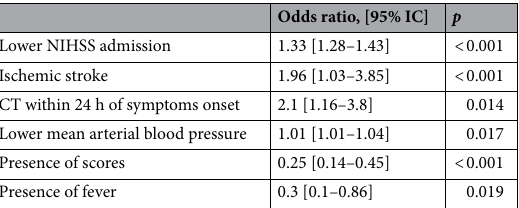
Table 3. Odd ratios associated to significant variables for favorable stroke outcome (mRS ≤